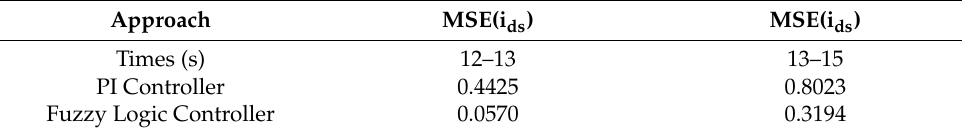
Table 2. Numerical comparison of PI controller and FLC under d -axis current.